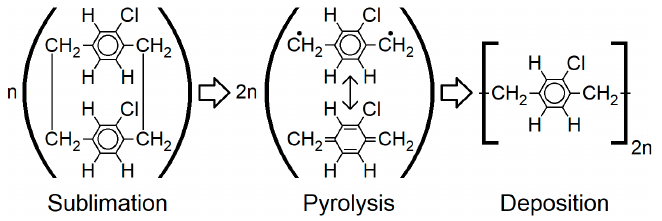
Figure 3. Molecular structure for each step of the Gorham CVD process for the deposition of Parylene [27].